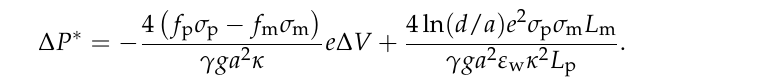
( a ) Pressure dependence of the average translocation velocity Equation (28) (solid curve) and the drift Formula (31) (circles). ( b ) Translocation time τ p from Equation (29) (solid curve) and the drift Equation (33). In ( a ), the experimental polymer velocity data was taken from Figure S3 of the supporting information of Ref. [33]. The average escape time data in ( b ) is from Figure 4b of Ref. [33]. The numerical values of the model parameters are given in the main text. The results are from Ref.